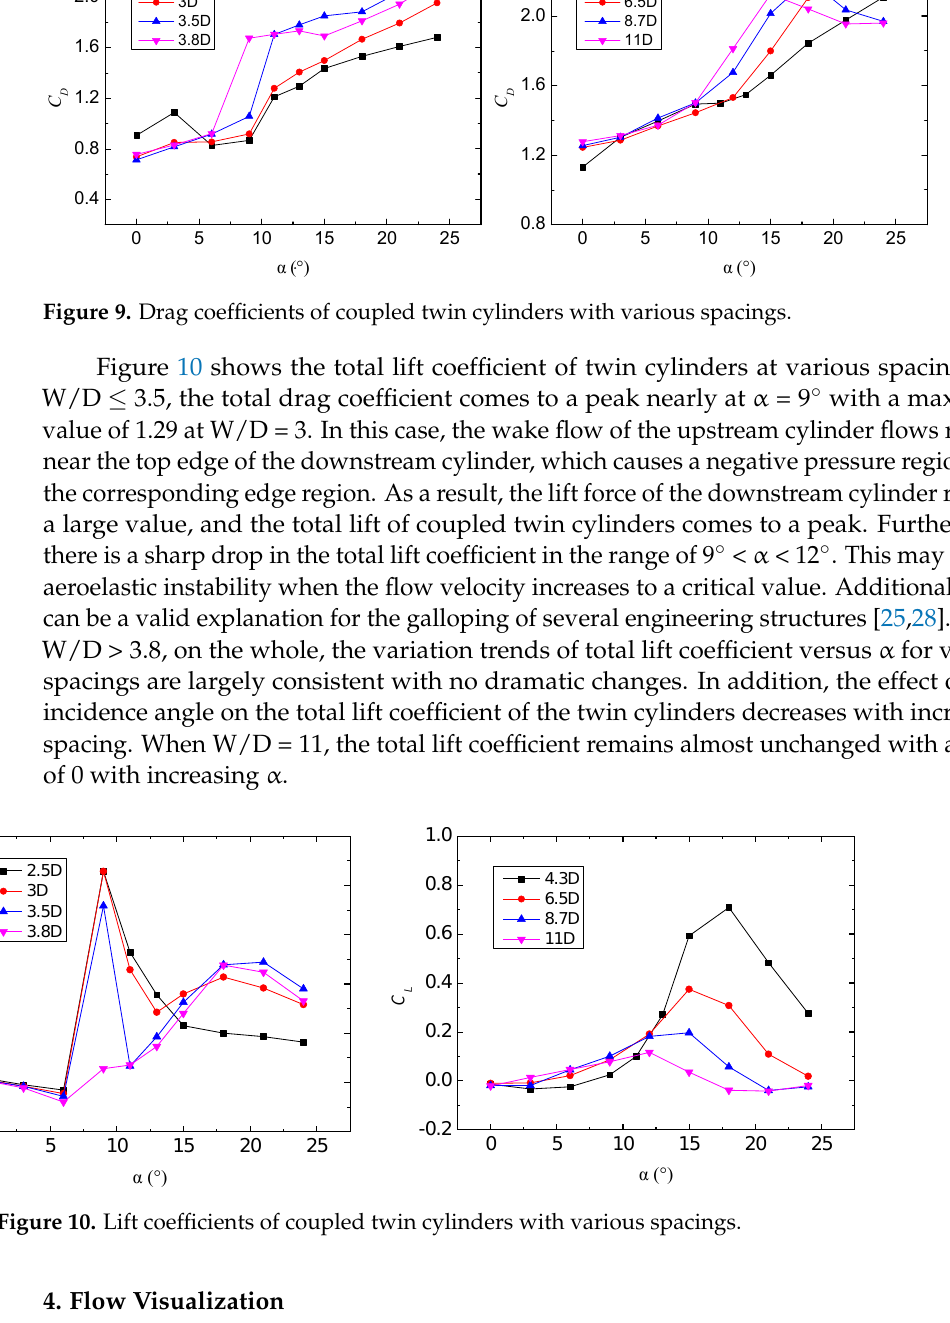
Figure 10. Lift coefficients of coupled twin cylinders with various spacings.